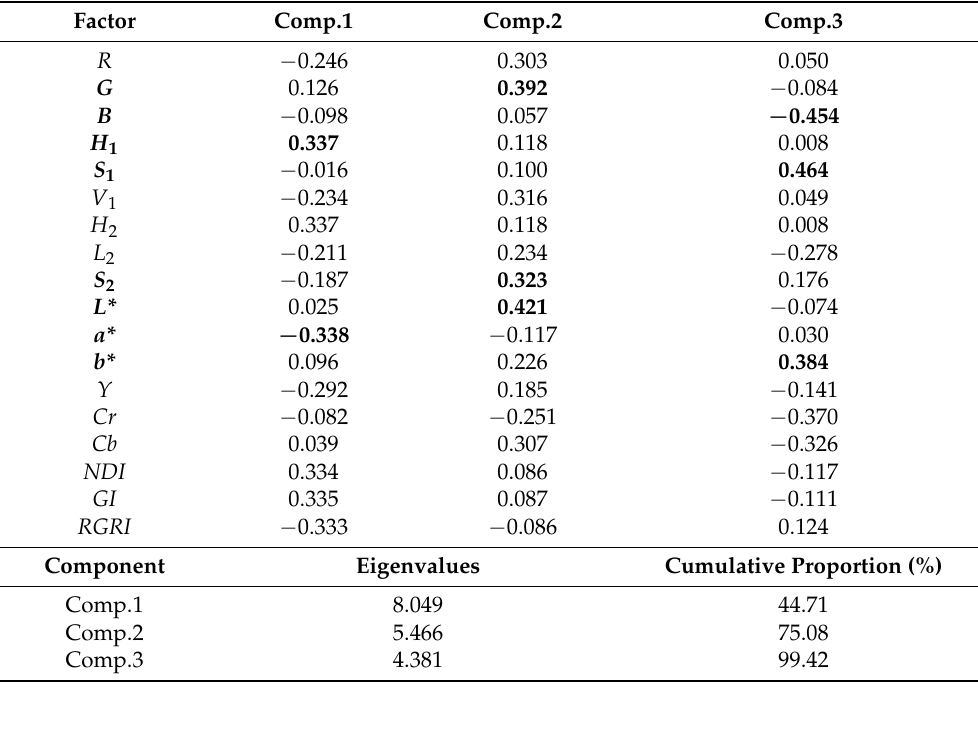
Table 3. Result of the principal component analysis by color index.